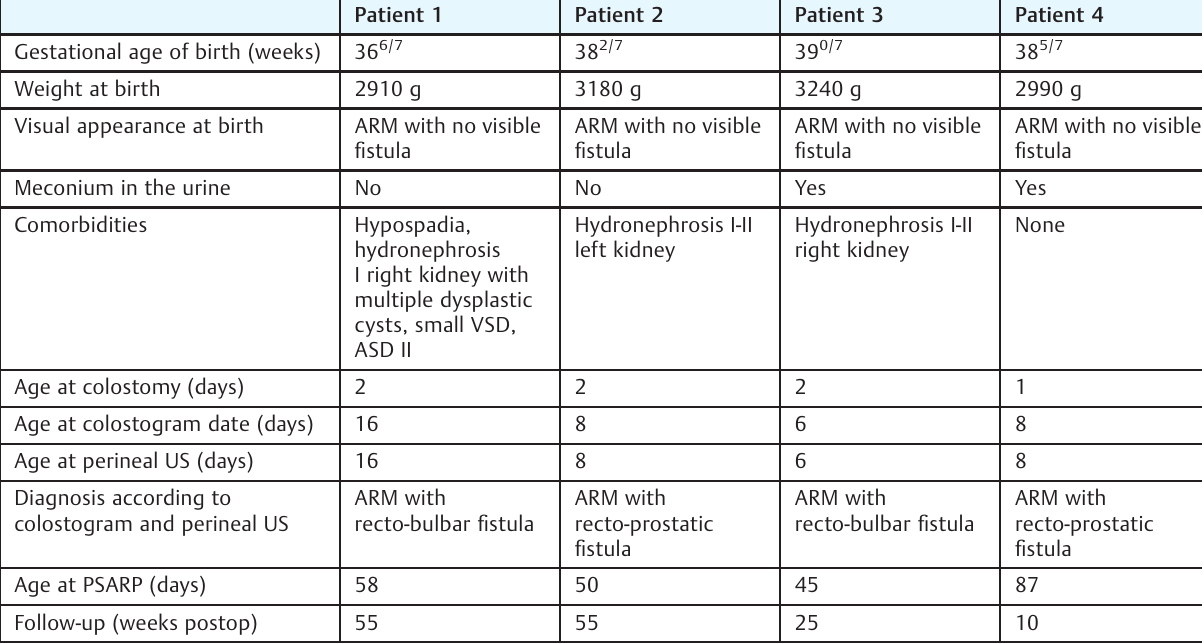
Table 1 Clinical data of the reported